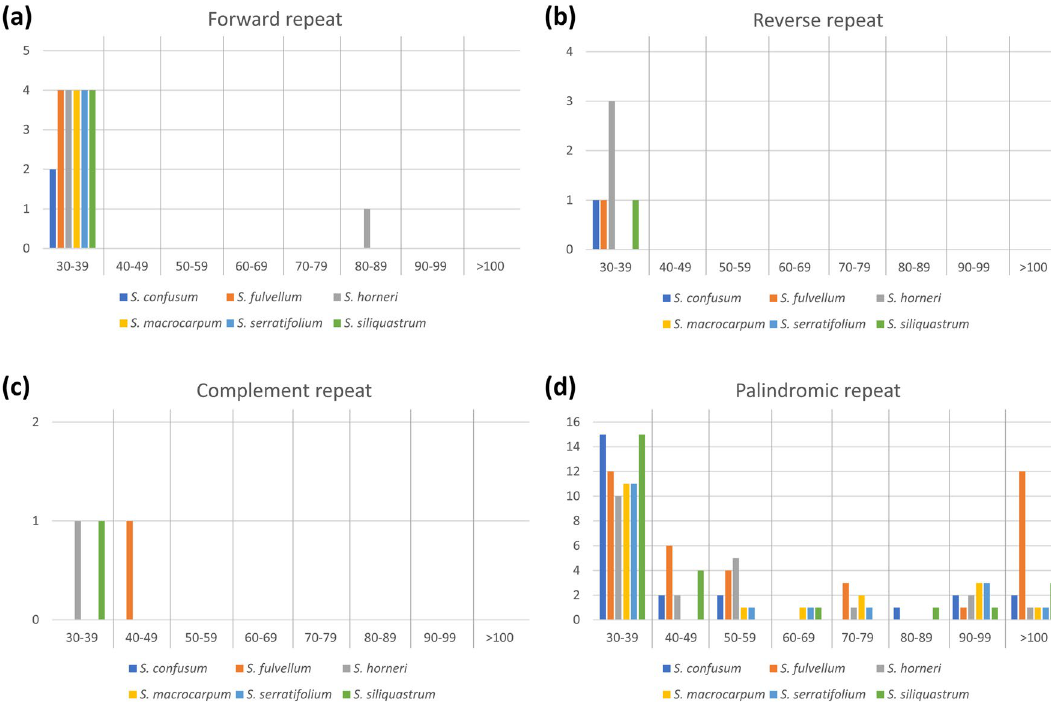
Figure 3. The longer repeat analysis of chloroplast genomes of the six Sargassum species. Frequency of ( a ) forward, ( b ) reverse, ( c ) complete, ( d ) palindromic repeats. The x-axis: repeat length; the y-axis: copy